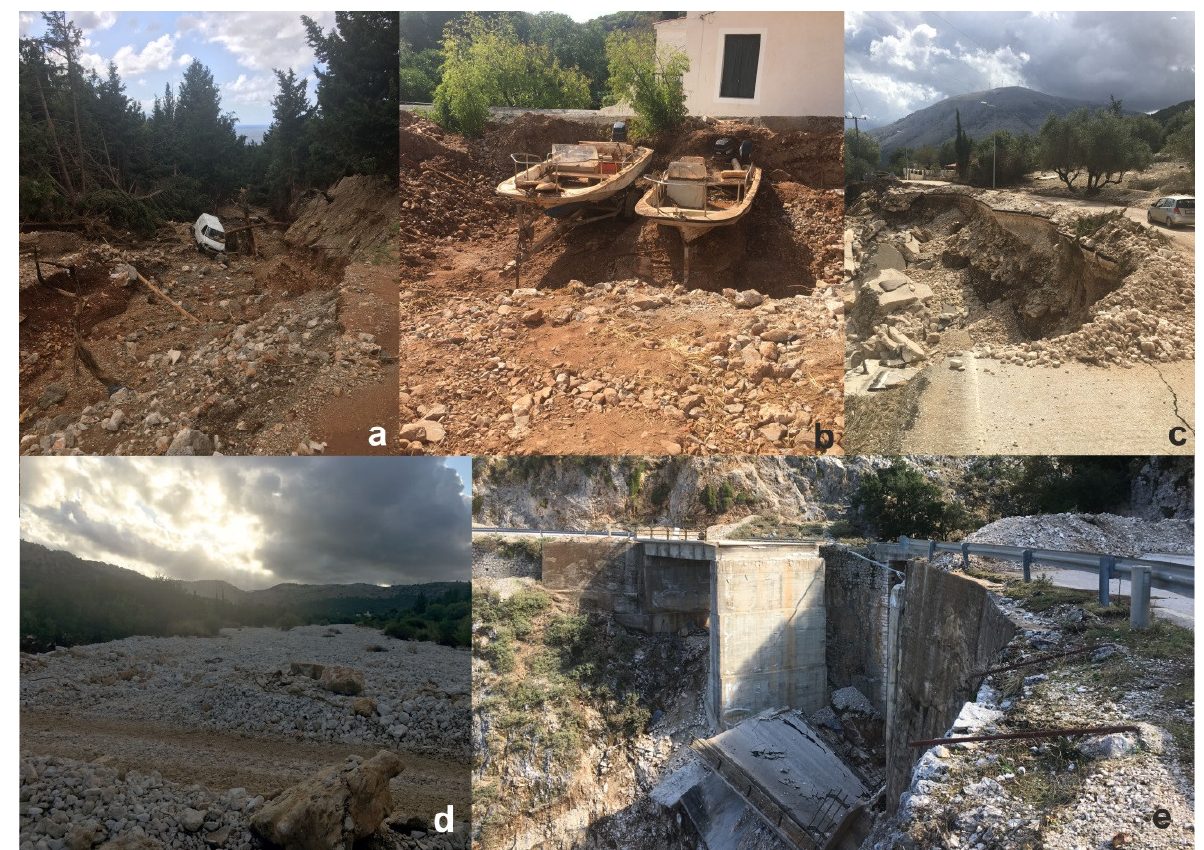
Figure 11. Characteristic damages in Cephalonia Island following Medicane Ianos: ( a ) Riverbank erosion, ( b ) debris flow within a rural community, ( c ) road embankment failure, ( d ) extensive debris flow, and ( e ) bridge collapse.